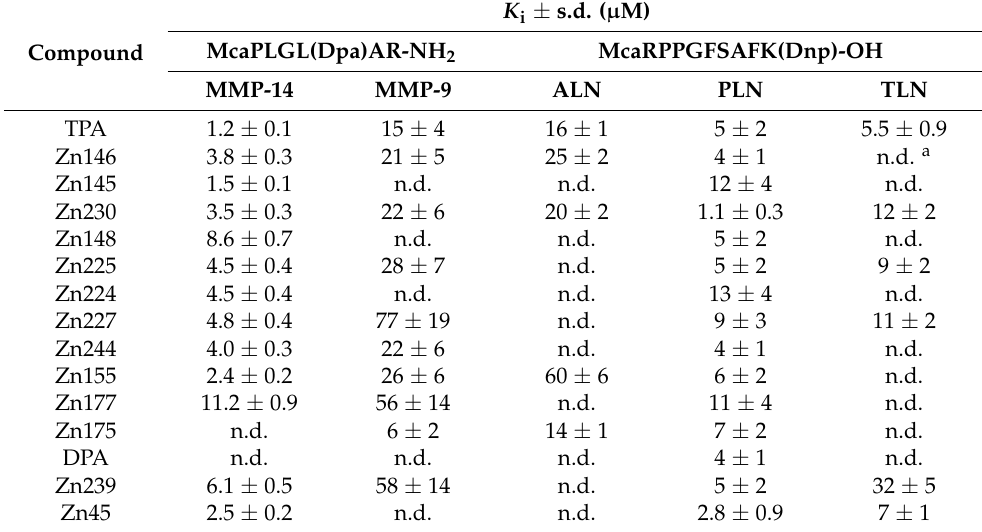
Table 1. K i values of the TPA, DPA and TPED derivatives for MMP-14, MMP-9, ALN, PLN and TLN. K i values determined for both bacterial and human metalloproteases using two different fluorescence quenched peptide substrates, McaRPPGFSAFK(Dnp)-OH (for TLN, PLN and ALN) and McaPLGL(Dpa)AR-NH 2 (for MMP-9 and MMP-14). The concentration of the substrates used was 4 µ M except for ALN where it was 5 µ M and the highest concentration of the inhibitor compounds tested was 100 µ M. K i values were only obtained for compounds where 100 µ M of the compound reduced the enzymatic activity by 60% or more, as described in the main text. Compound and enzyme were pre-incubated for 30 min at room temperature and the reaction was started by the addition of substrate as described in Materials and Methods. K i ± s.d. ( µ M) McaPLGL(Dpa)AR-NH 2 McaRPPGFSAFK(Dnp)-OH Compound MMP-14 MMP-9 ALN PLN TLN